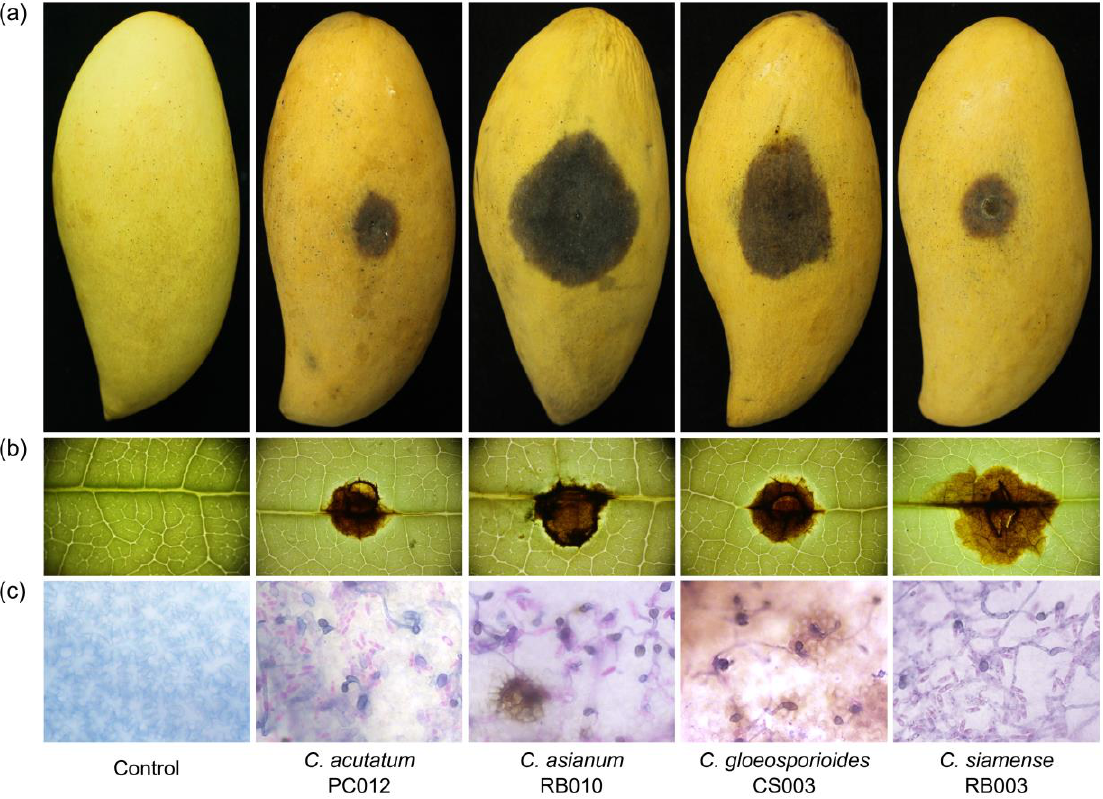
Figure 5. Pathogenicity assay of four different Colletotrichum species on NDMST mango; visual anthracnose symptoms developed on fruit ( a ), leaves ( b ) at 5 days after inoculation, and appressoria and spores developed on leaves at 24 h after inoculation ( c ). The test was performed on all isolates; only a representative of each species is shown here.